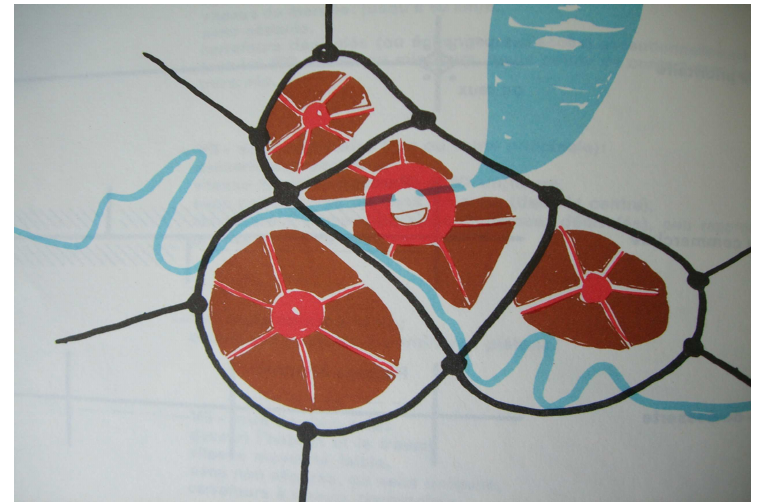
Figure 2. Functionalist urban planning approach according to Biermann, in 1959 Legend: Biermann’s plan with circular pattern of expressways and separation of functions Source : Biermann,